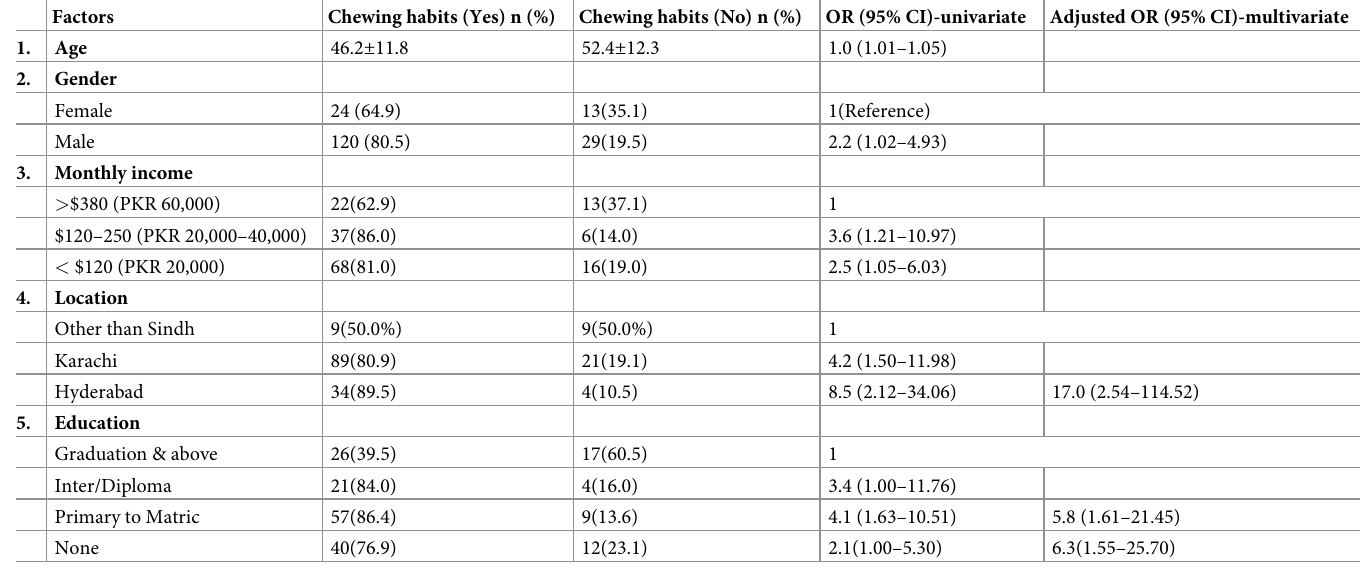
Table 2. Model 1, univariate and multivariate regression analysis of SES variables with chewing habits as dependent variables in OSCC patients.